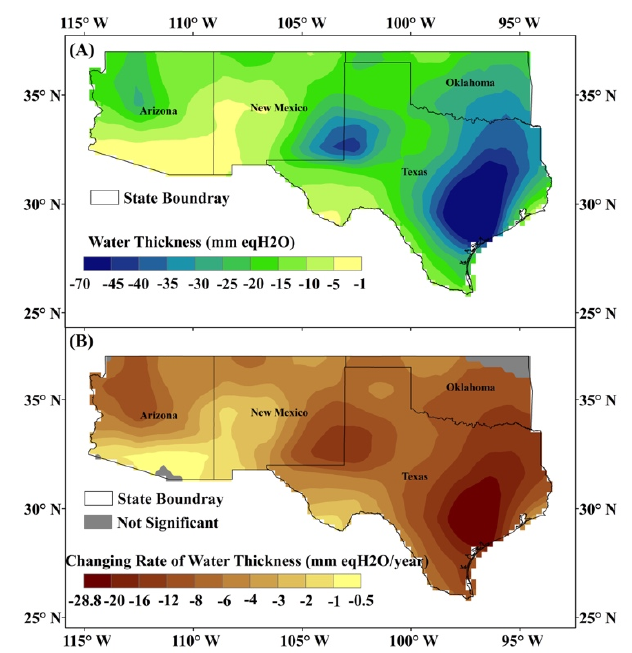
Figure 2. ( A ) Mean r elative water thickness and its ( B ) changing rates across the Southwest US from 2003 to 2014 2003 to 2014